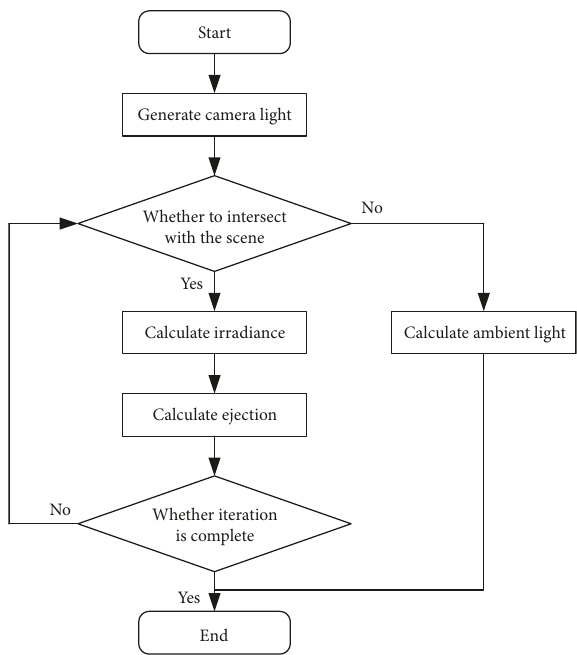
Figure 1: Raytracing